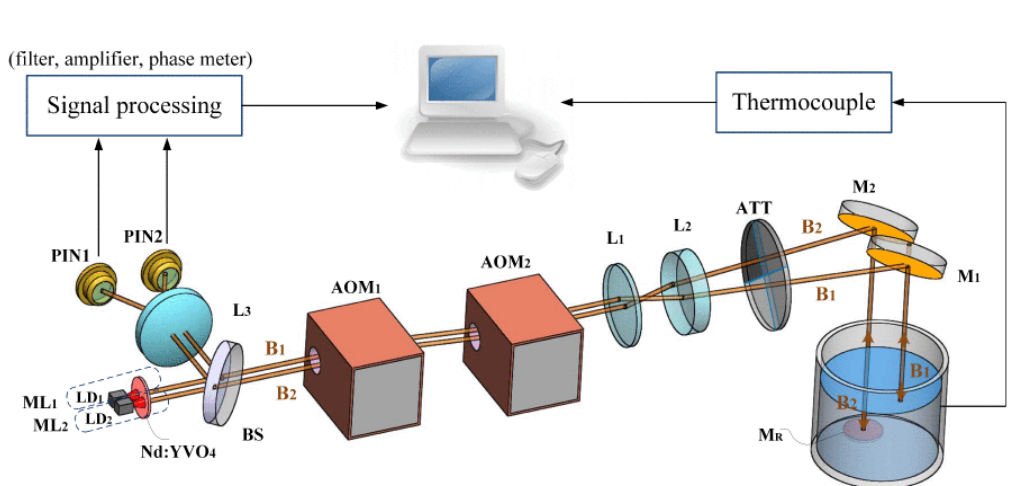
Figure 14. Experimental setup of the liquid refractive index measurement. LD 1 , LD 2 , laser diodes; ML 1 , ML 2 , microchip lasers; BS, beam splitter; PIN 1 , PIN 2 , detectors; AOM 1 , AOM 2 , acousto-optics modulators; L 1 , L 2 , L 3 , lenses; ATT, attenuator, M 1 , M 2 , M R , mirrors. (Figure reproduced from Ref. [74]).